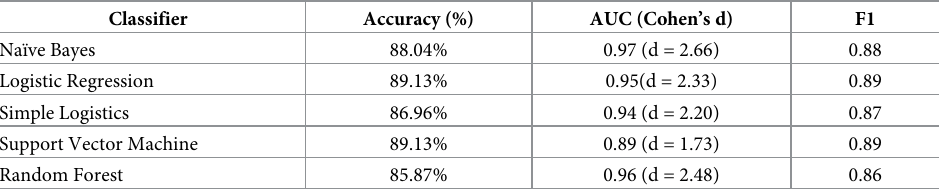
Table 5. Accuracies as measured by % correct, AUC and F1 obtained by five different ML